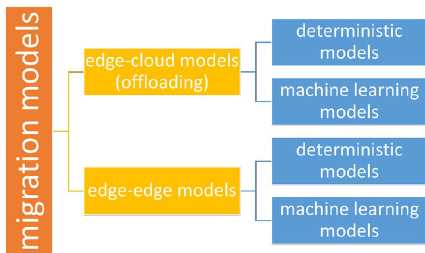
Figure 1. Categories of migration